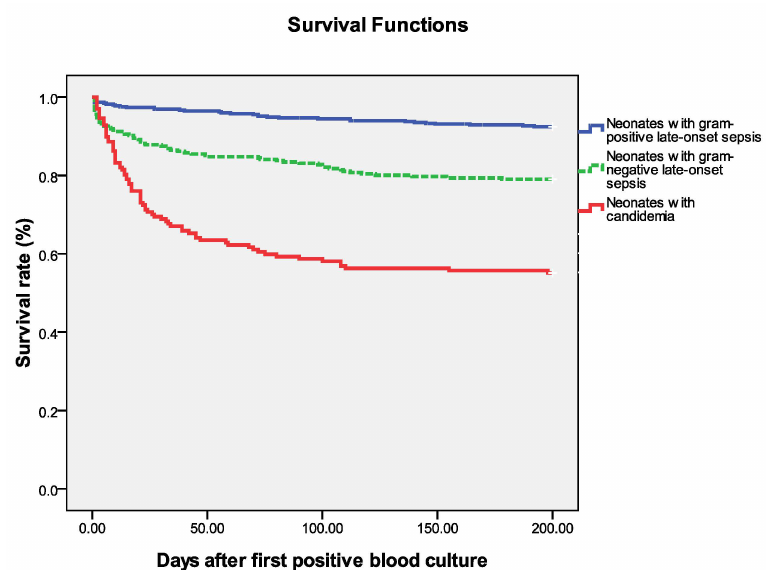
Figure 2. Survival following positive blood culture from 124 neonates with candidemia and 713 neonates with late-onset sepsis in the NICU. The Kaplan–Meier graph is stratified by Gram-positive, Gram- negative organisms, and candida species. The y -axis is the proportion